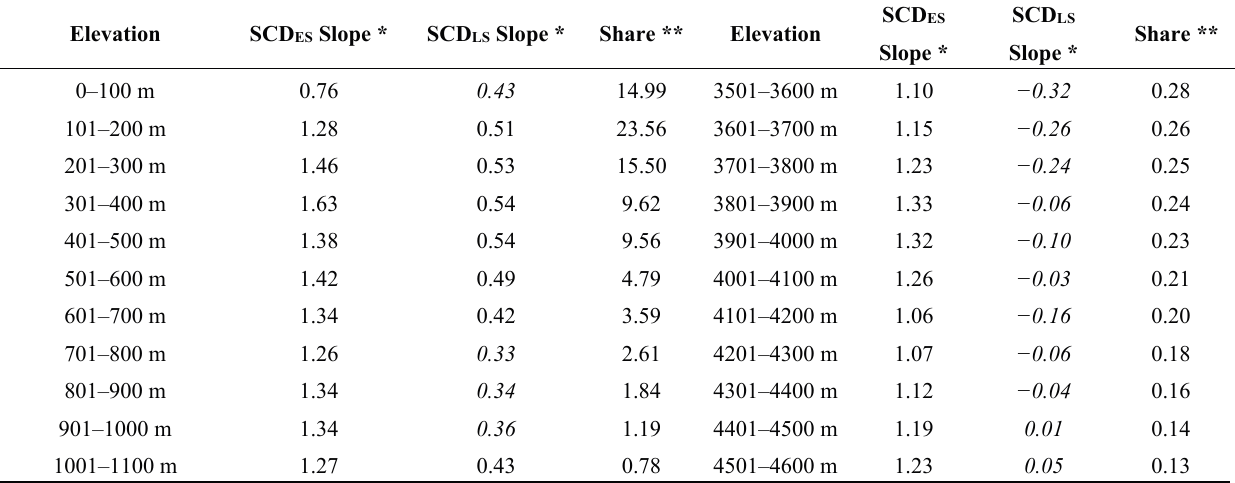
Table 6. Trend of SCDES and SCDLS per elevation level between 1986/1987 and